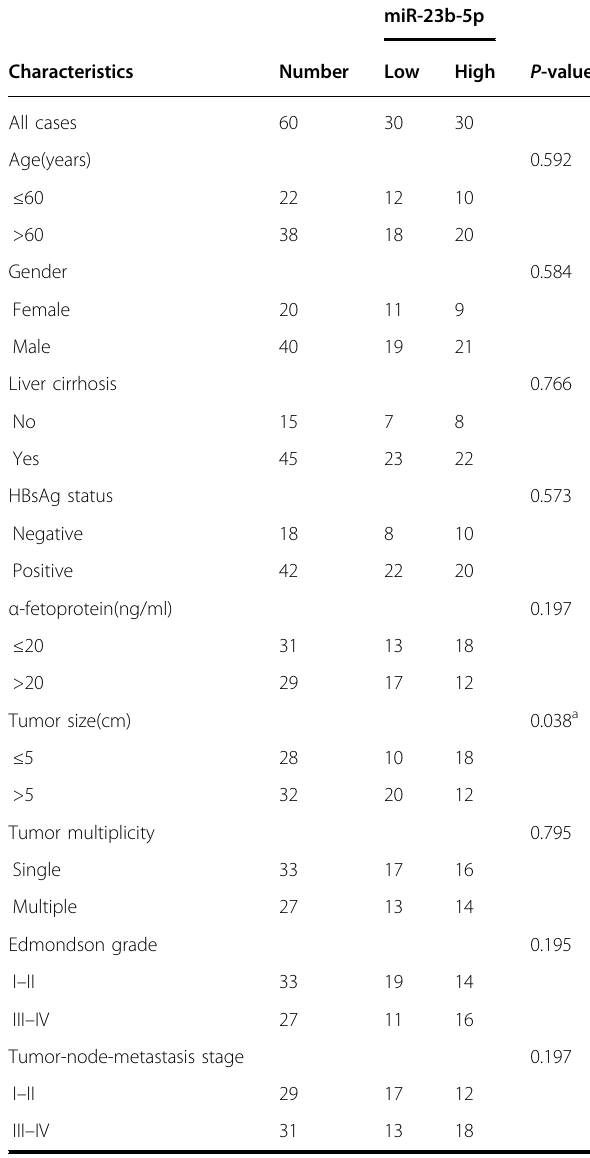
Table 1 Association between miR-23b-5p expression and clinicopathologic features of patients with hepatocellular